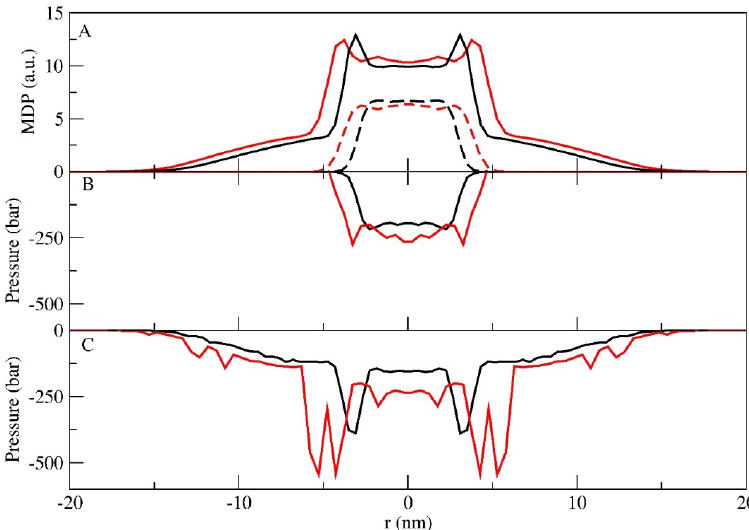
Figure 5. MDPs ( A ) for PEO (full line) and PPO (dash line). Tangential pressure profiles along the z direction for PPO ( B ) and PEO ( C ). In all figures, the LS and LU are shown in black and red, respectively.